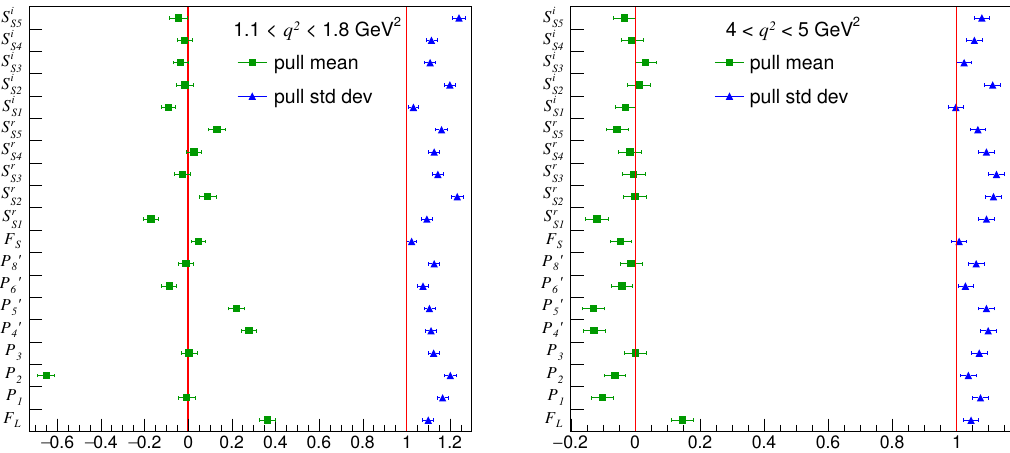
Figure 12 . Summaries of the (green) means and (blue) standard deviations of the pull distribution for the optimised P-wave observables, PS i , in two narrow bins of q 2 . The red lines are references at 0 and